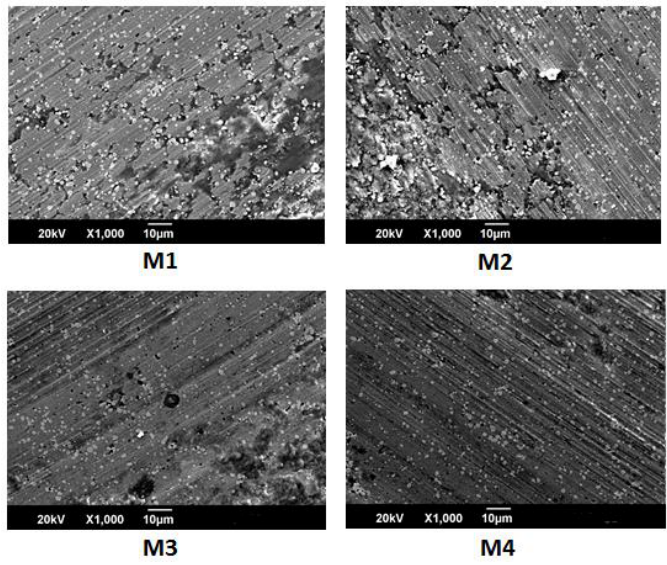
Figure 8. SEM micrographs of the wear tracks for the ( a ) M1; ( b ) M2; ( c ) M3; and ( d ) M4 samples.